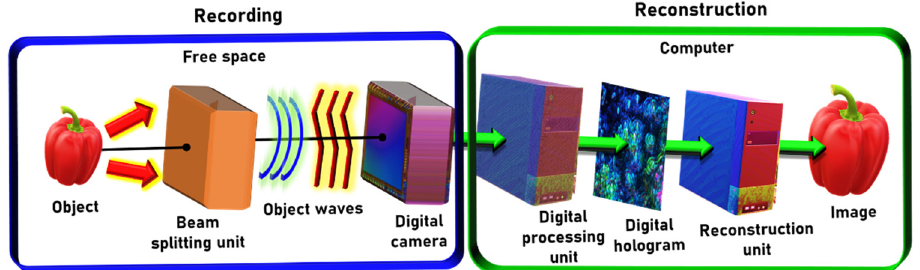
Figure 1. Recording and reconstruction of a hologram in a general self-interference digital holog- raphy